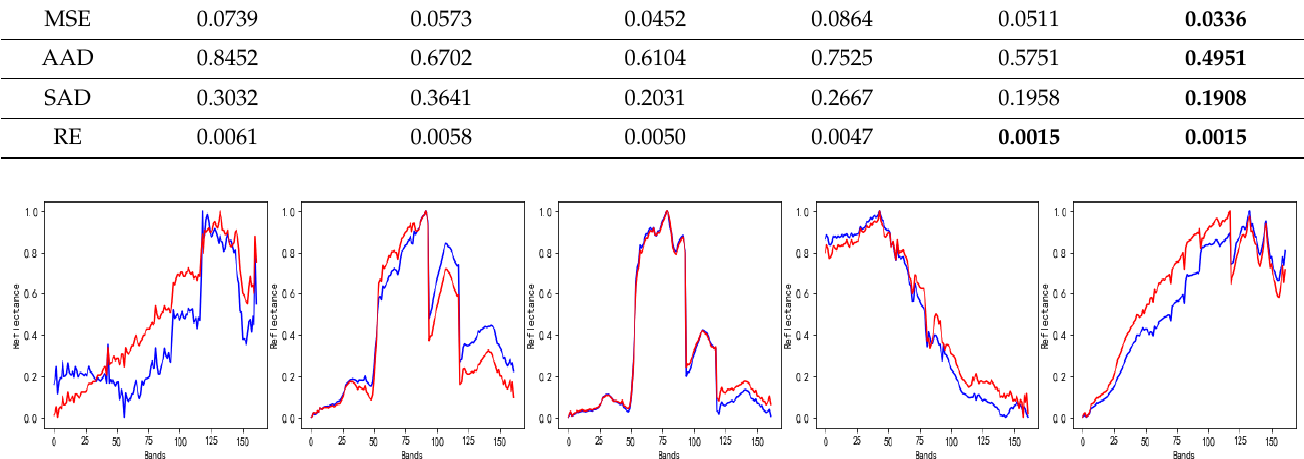
Figure 12. Comparison of the reference endmember (red line) with the endmember extracted by GBM_AE (blue line) on Urban. From left to right for different endmembers: asphalt, grass, tree, roof, and dirt.